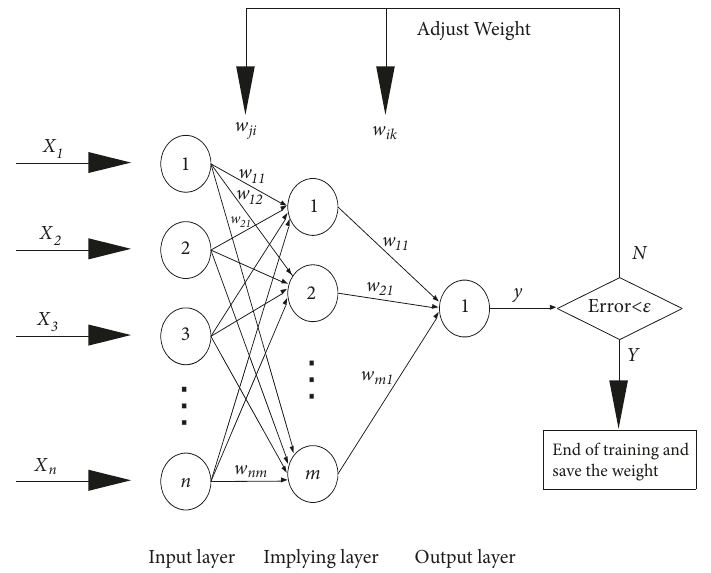
Figure 3: Typical 3-layer BP network flow chart.